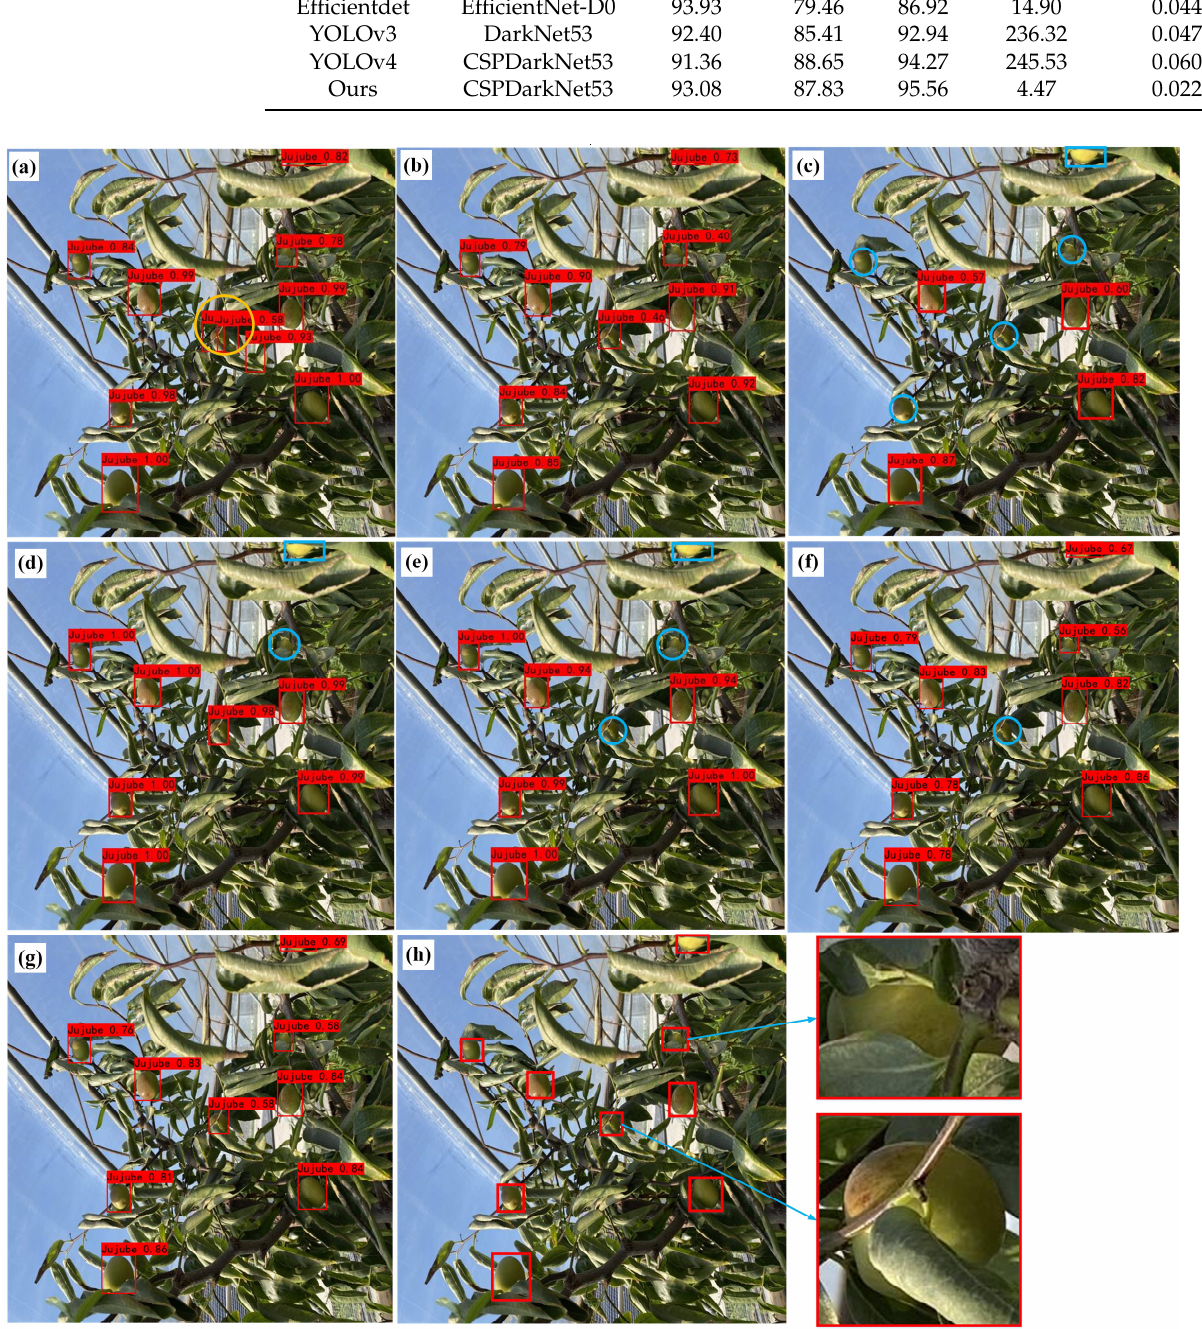
Figure 8. Recognition results with different models for the occluded scene. ( a ) Faster R-CNN, ( b